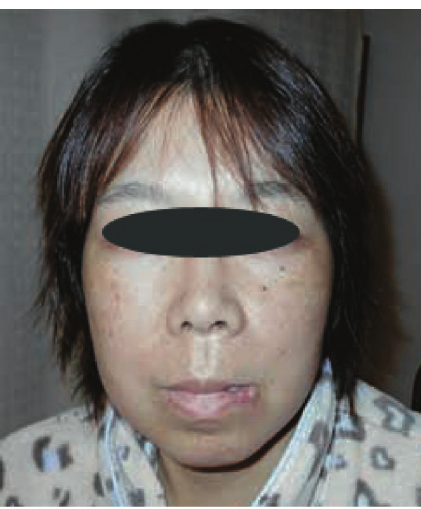
Figure 1: Extraoral view at first medical examination of lacerative scar in the lower lip and swelling in the nasolabial sulcus.